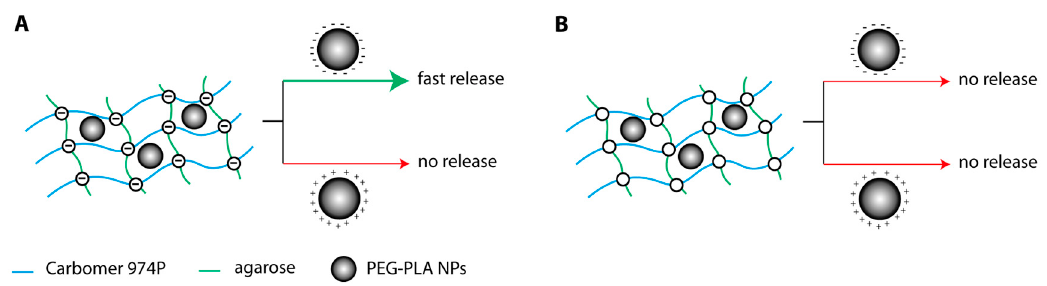
Figure 3. Schematic representation of NPs release from: ( A ) AC6 hydrogel at pH = 7.4; ( B ) AC6 hydrogel at pH = 5.